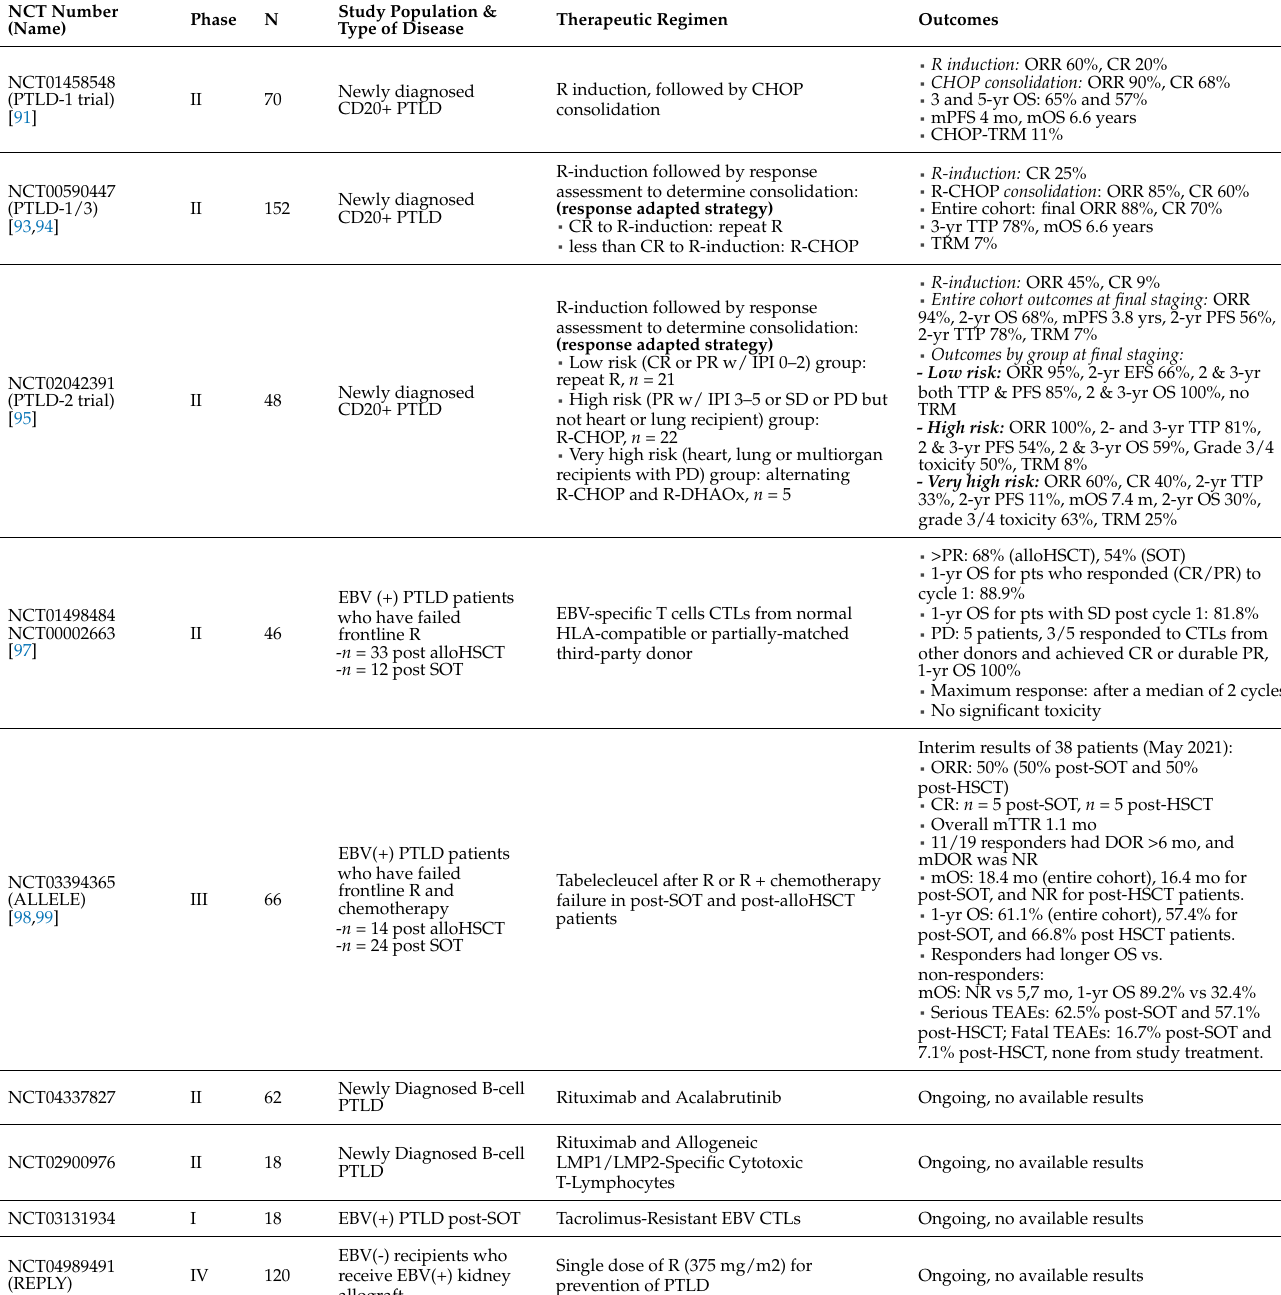
Tabelecleucel after R or R + chemotherapy failure in post-SOT and post-alloHSCT patients